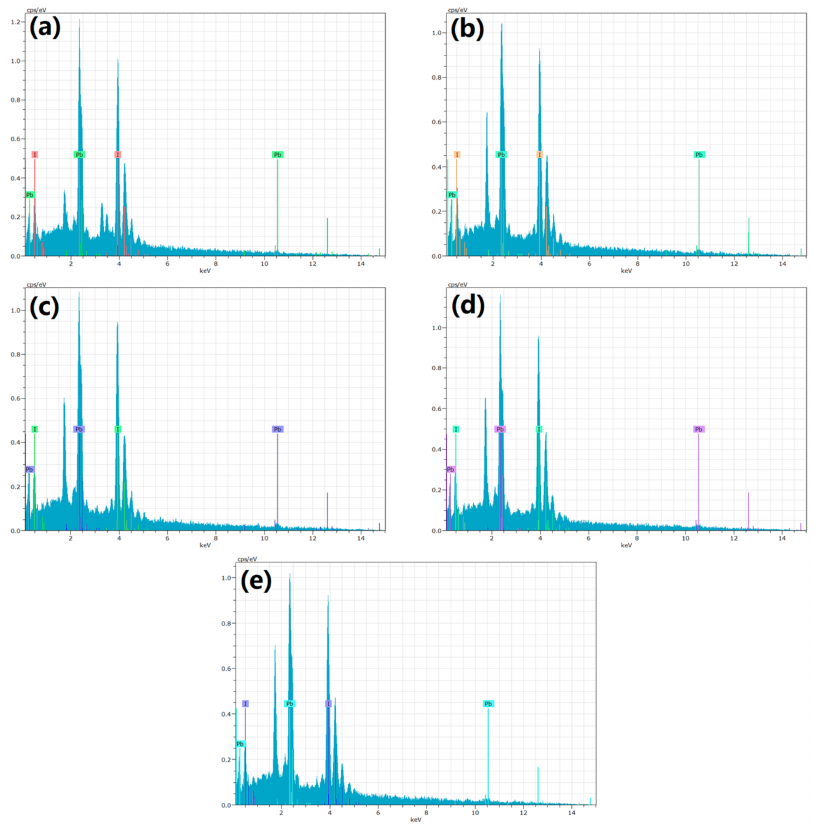
Figure 4. EDS spectral line pattern of A, B, C, D and E regions of MAPbI 3 thin films: ( a ) A region;